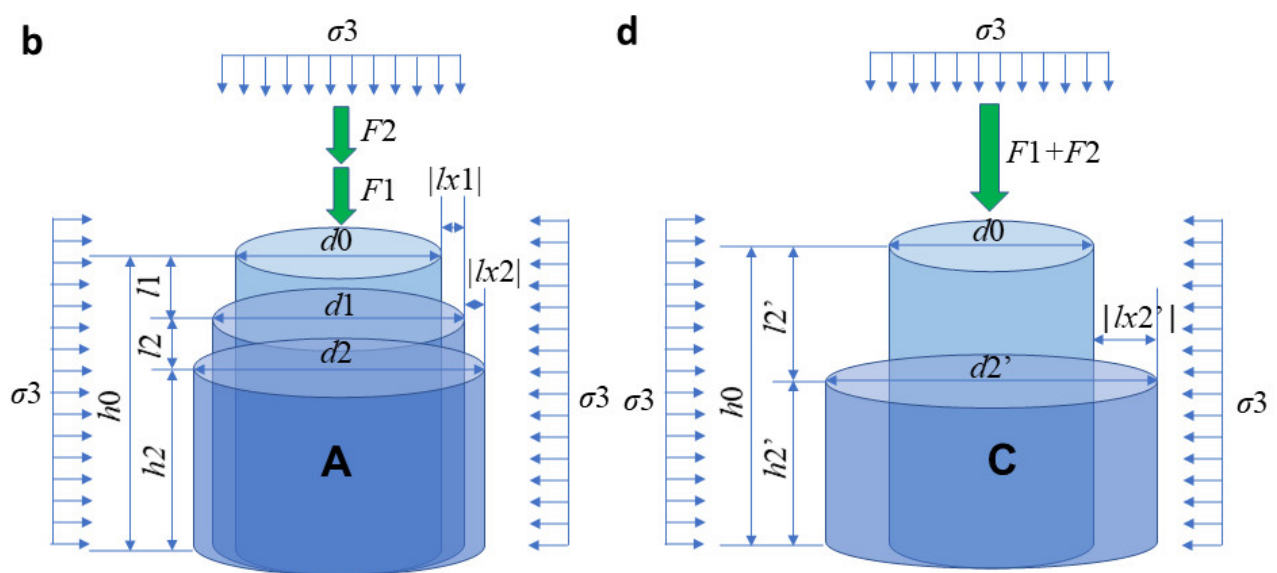
Figure 3. Illustration of SL process on specimen A and RL process on specimen B and C. ( a ) Specimen A is deformed under F 1 load. ( b ) Specimen A is continually deformed under another F 2 load after it reached a stable deformation state under F 1 load. ( c ) Specimen B is deformed under F 1 load. ( d ) Specimen C is deformed under ( F 1 + F 2 ) load.